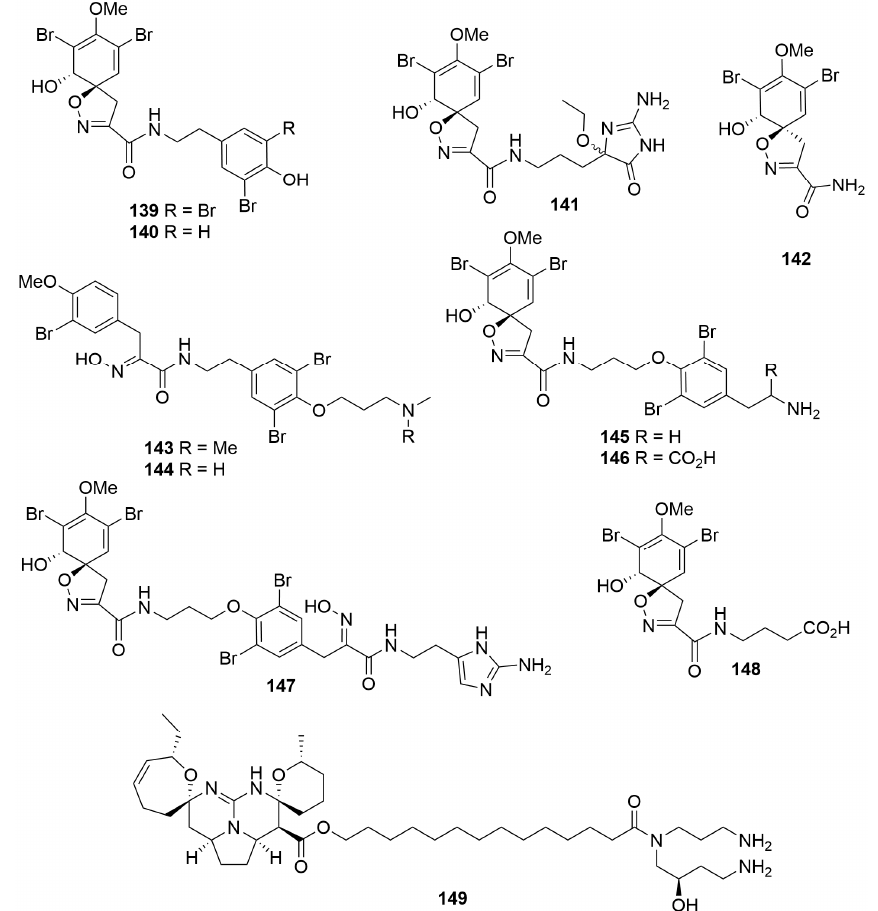
Figure 8. Compounds 139 to 149 .